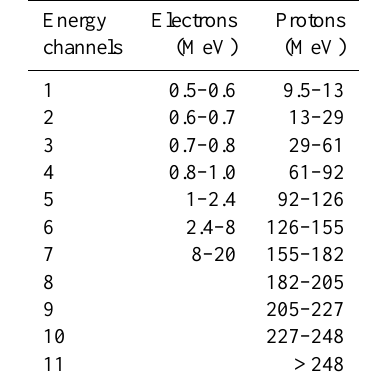
Table 1. Energy ranges corresponding to each virtual channel of the EPT instrument for electrons and